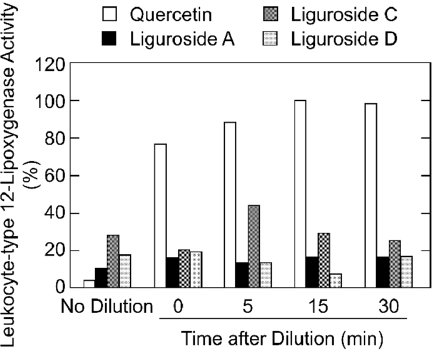
Figure 4. Reversibility analysis of the leukocyte-type 12-lipoxygenase inhibition. The leukocyte-type 12-lipoxygenase was preincubated with 6 μ M quercetin, liguroside A, liguroside C, and liguroside D, at 30 °C, for 5 min, and then the mixture was 200-fold diluted in the standard lipoxygenase reaction mixture. After 0, 5, 15, and 30 min, the mixtures were incubated with 25 μ M arachidonic acid at 30 °C, for 5 min. The reaction without dilution of inhibitors (no dilution) was also carried out. The relative enzyme activities, as compared with the activity without inhibitors, are shown. p -Coumaric acid, as a part of the ligurosides, showed no inhibition on the leukocyte-type 12- lipoxygenase activity, suggesting that the inhibitory effects of liguroside A and liguroside B can be attributed to the monoterpene unit with the hydroperoxy group [7]. On the other hand, monoterpene glycosides have the same backbone structure but did not have a hydroperoxy group (such as kudingoside A and lipedoside B-III) contained in the tea (Figure 1), and did not inhibit the enzyme activity (Figure 5). We reduced a hydroperoxy group in liguroside A using triphenylphosphine. The structure of the reduced compound was confirmed by mass spectrometry as kudingoside B, as described previously (Figure 1) [7]. The resultant compound, kudingoside B, showed a lower inhibitory effect on the enzyme (Figure 5), strongly suggesting that the hydroperoxy group of ligurosides played a key role in the irreversible inhibition of the leukocyte-type 12-lipoxygenase by the compounds. The detailed mechanism of the enzyme inhibition by the hydroperoxy group of ligurosides remains to be elucidated. In the suicidal inactivation of the enzyme, 15-hydroperoxy- 5,8,11,13-eicosatetraenoic acid was further converted to 14,15-leukotriene A 4 , an epoxide product, by the leukocyte-type 12-lipoxygenase, itself, and was incorporated into the enzyme protein, by a covalent binding [12]. In contrast, 12-hydroperoxy-5,8,10,14-eicosatetraenoic acid, a major product of the leukocyte-type 12-lipoxyganase, did not inactivate the enzyme as fast as the 15-hydroperoxy- 5,8,11,13-eicosatetraenoic acid, and slowly incorporated into the enzyme that did not bind covalently [12]. It is well-known that terpenes, such as linalool and geraniol can autoxidize and form oxidation products such as hydroperoxides, when exposed to air [14]. It was also reported that the hydroxy-